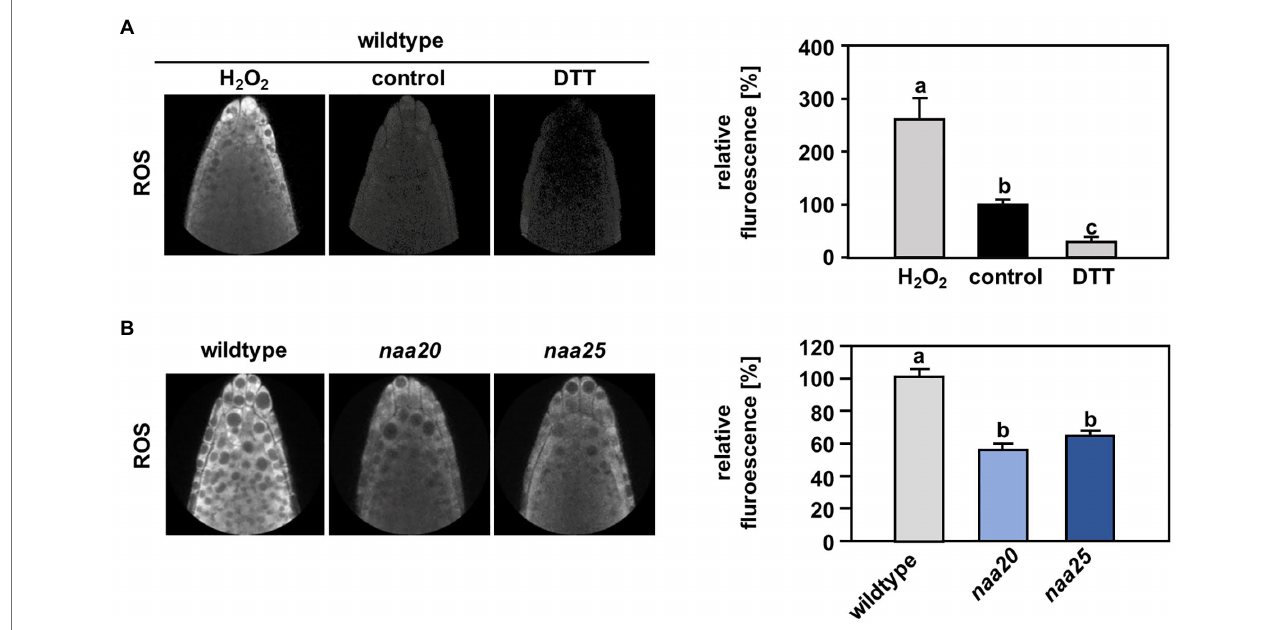
FIGURE 7 | The cytosol of NatB mutants is more reduced than in the wildtype. To determine the reactive oxygen species (ROS) level in the cytosol of roots cells, wildtype seedlings were grown on ½ MS medium under short day conditions. After six days, the plants were transferred to liquid ½ MS medium supplemented with the ROS indicator H 2 DCFDA (2 ′ ,7 ′ -dichlorodihydrofluorescein diacetate), and the ROS-triggered fluorescence intensity was determined by non-invasive confocal laser scanning microscopy as described in material and methods. (A) Representative images of wildtype roots treated for 30 min with water (control, 100 %) or water supplemented with either 100 mM H 2 O 2 or 10 mM dithioerythritol (DTT). The relative ROS-triggered fluorescence upon H 2 O 2 and DTT treatment was quantified with respect to control conditions in >5 roots. (B) Representative fluorescence images of roots from the wildtype and plants depleted of the catalytic ( naa20 ) or the auxiliary NatB subunit ( naa25 ) treated with H 2 DCFDA. The relative ROS-triggered fluorescence in naa20 and naa25 was quantified with respect to the wildtype in >5 roots. Data given as means ± SE. Different letters indicate individual groups identified by pairwise multiple comparisons with a Holm-Sidak, One-way ANOVA ( p < 0.05, n ≥